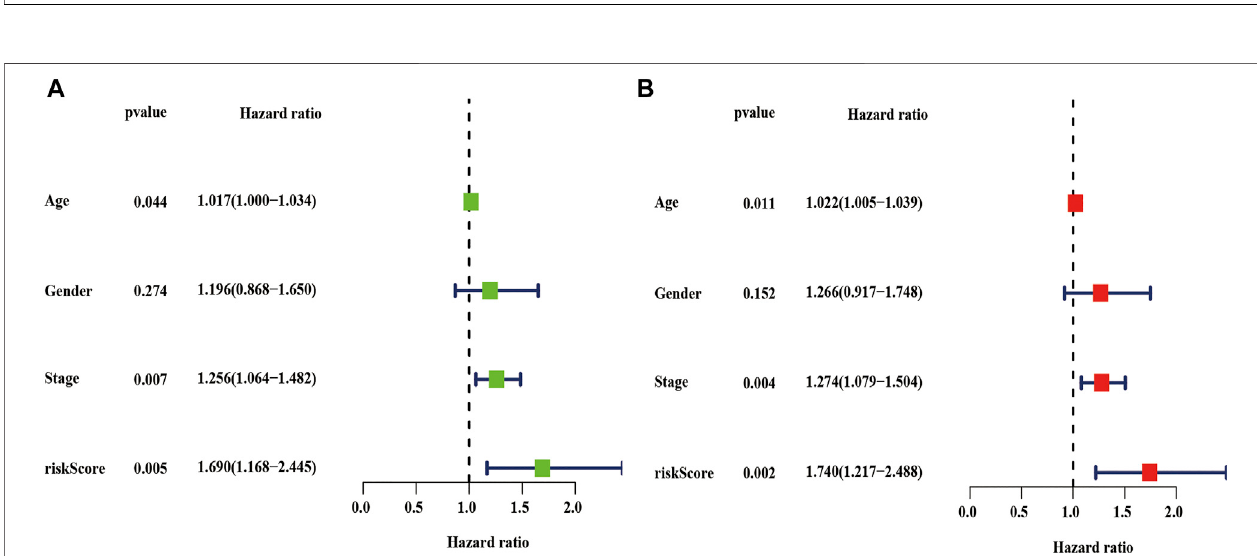
FIGURE 10 | Univariate and multivariate cox analyses of the risk score. (A – B) Univariate (A) and multivariate (B) Cox analyses of the risk score in the TCGA entire dataset. TCGA, the cancer genome atlas.